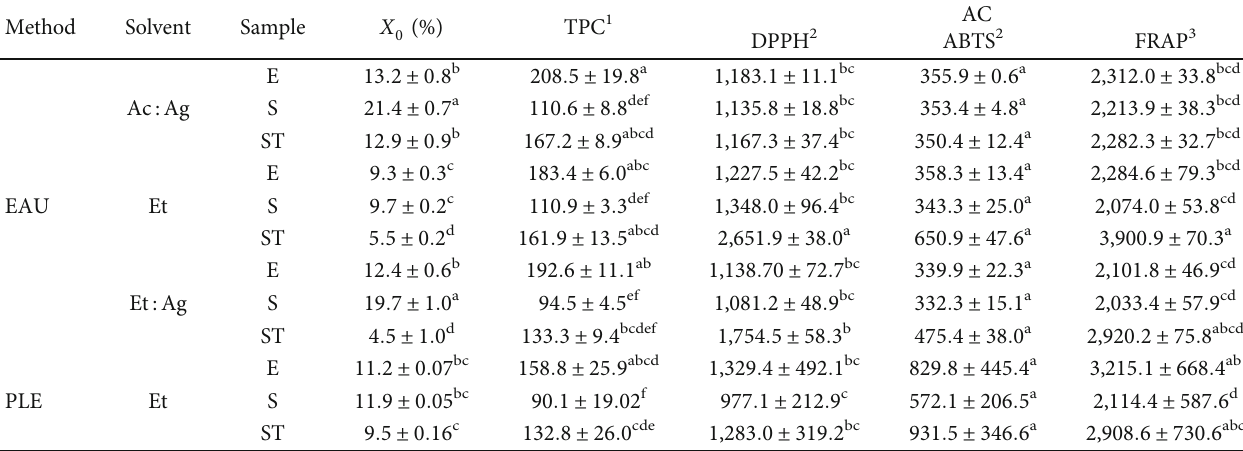
Table 1: Global yield ( X ), total phenolic content (TPC), and antioxidant capacity (AC) of extracts obtained by UAE and PLE. 0 Method